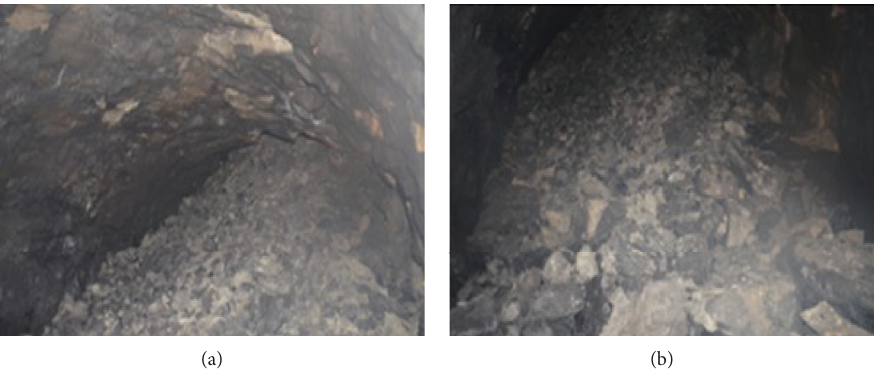
Figure 1: Roadway caving section. (a) Typical field 1. (b) Typical field 2.